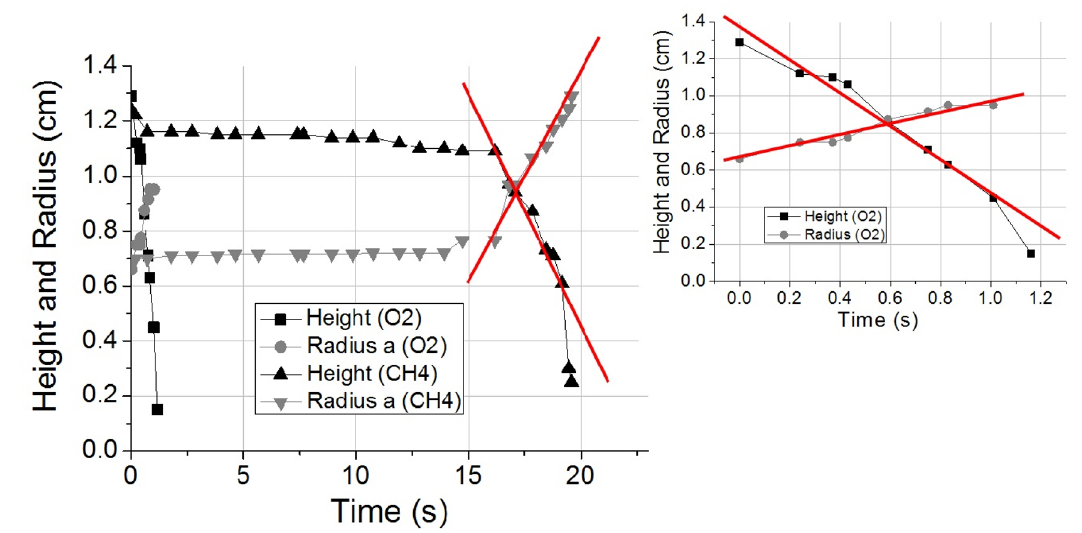
+ 60% O ; (b) magnification 4 2